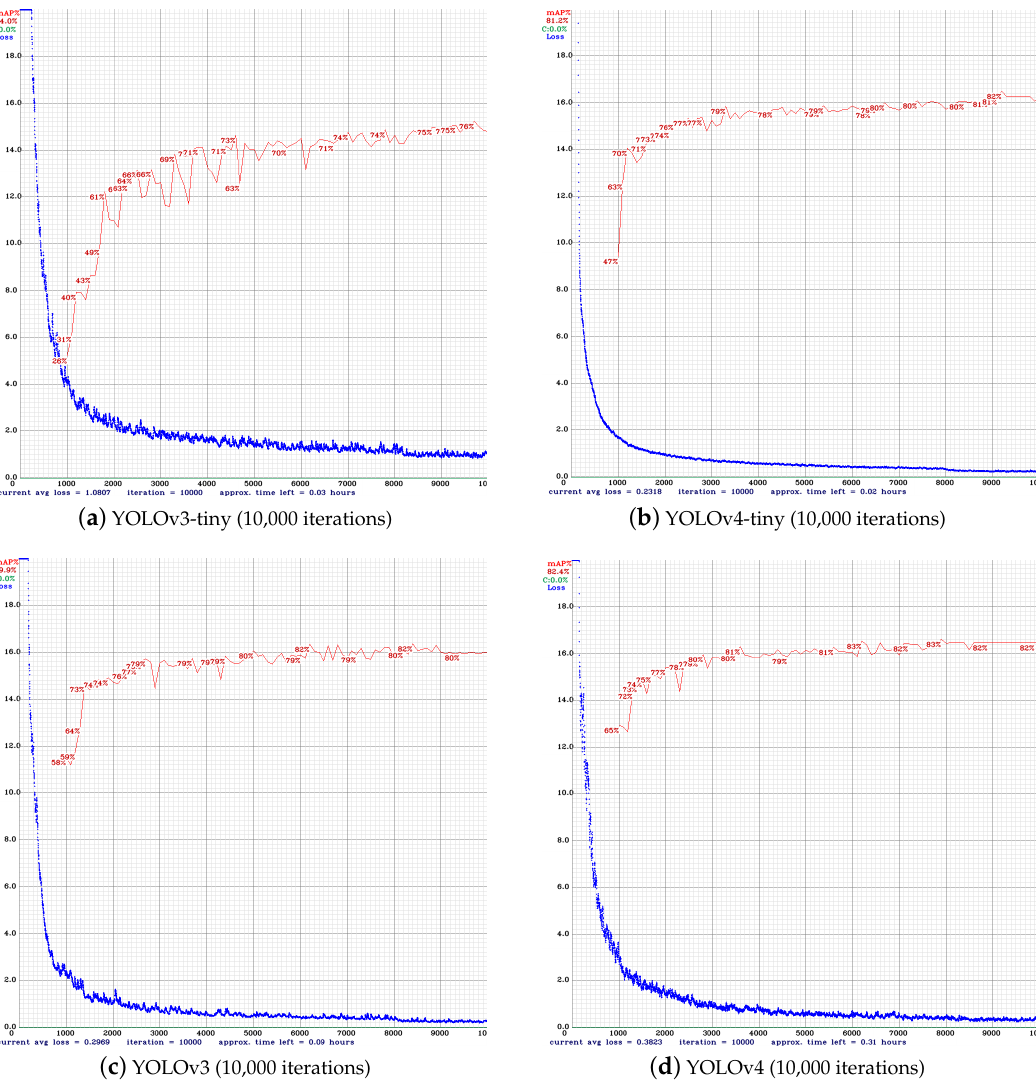
Figure 10. YOLO training results after 10,000 iterations: YOLOv4-CSPdarknet53 shows higher loss with the Mish function as compared to YOLOv4-tiny and YOLOv3-darknet53 because the leaky ReLU activation performs better in terms of minimizing the loss, though at the cost of some